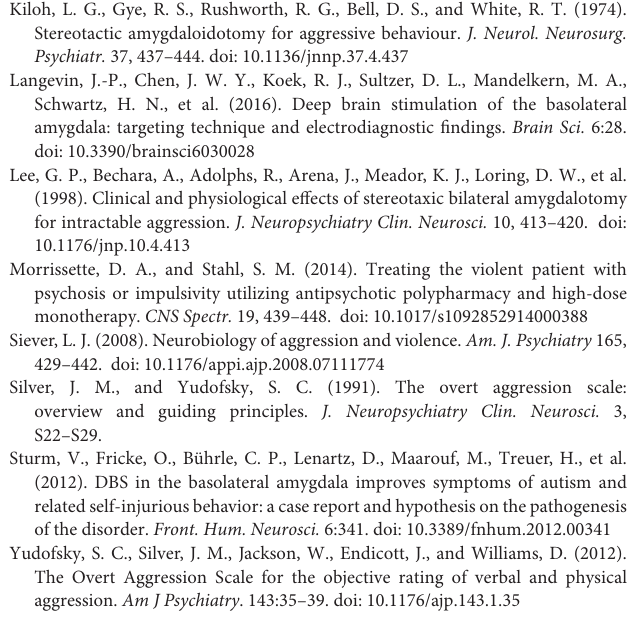
Supplementary Figure 1 | (A) Cortical thickness segmentation in patients treated with amygdala lesion (I,II) and in controls (III,IV) . (B) Magnetic resonance imaging of patients treated with amygdala ablation (Cases 1–3, images I–III, respectively) before and after surgery in axial (top row) and coronal (bottom row)